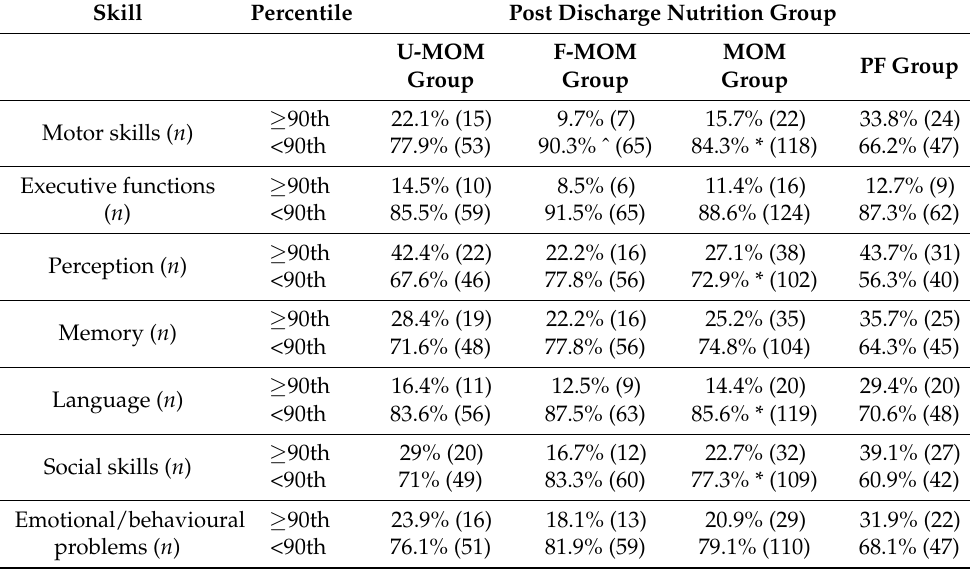
Table 3. Results of the Five to Fifteen Parent